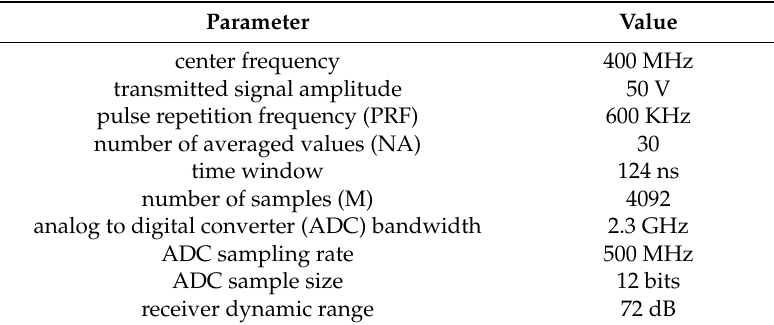
Table 1. The UWB impulse radar